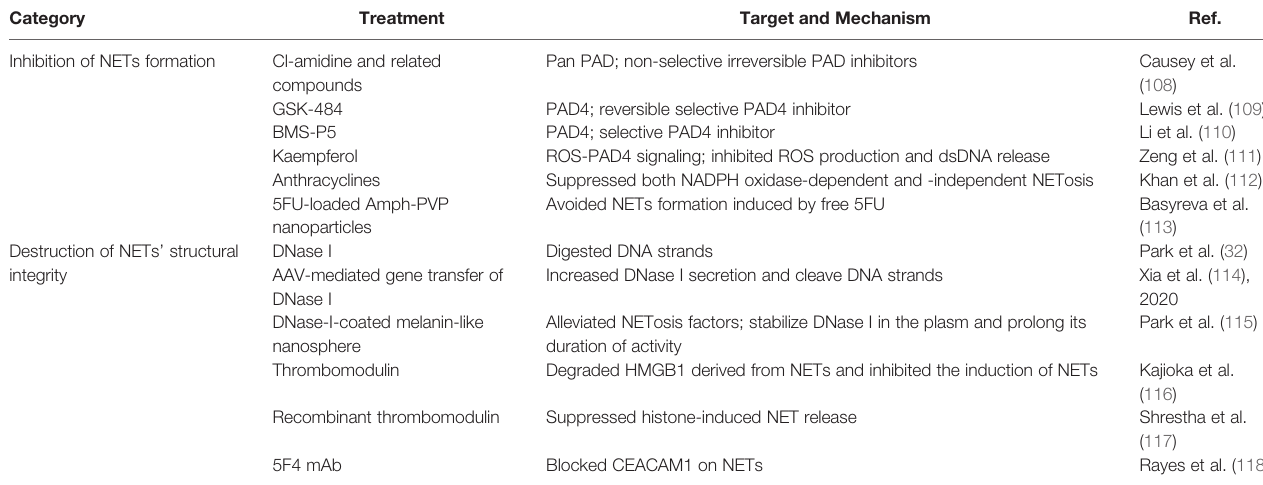
TABLE 1 | Published key therapeutics targeting NETs to